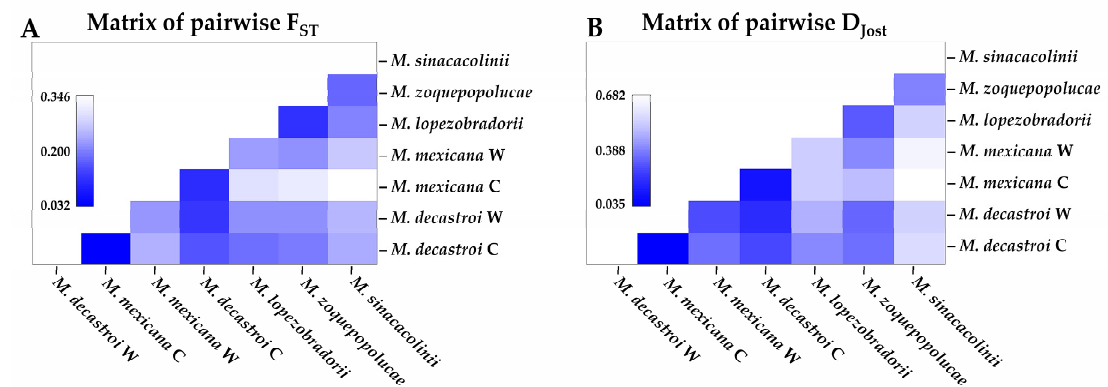
Figure 6. Pairwise F ST and D JOST values between the five Magnolia species studied in Puebla and Veracruz, Mexico, visualized as a heatmap. W = wild, C = cultivated. ( A ) Below the diagonal pairwise F ST values are tabulated. ( B ) Pairwise D JOST values are tabulated. Locality metadata can be found in Table 5.